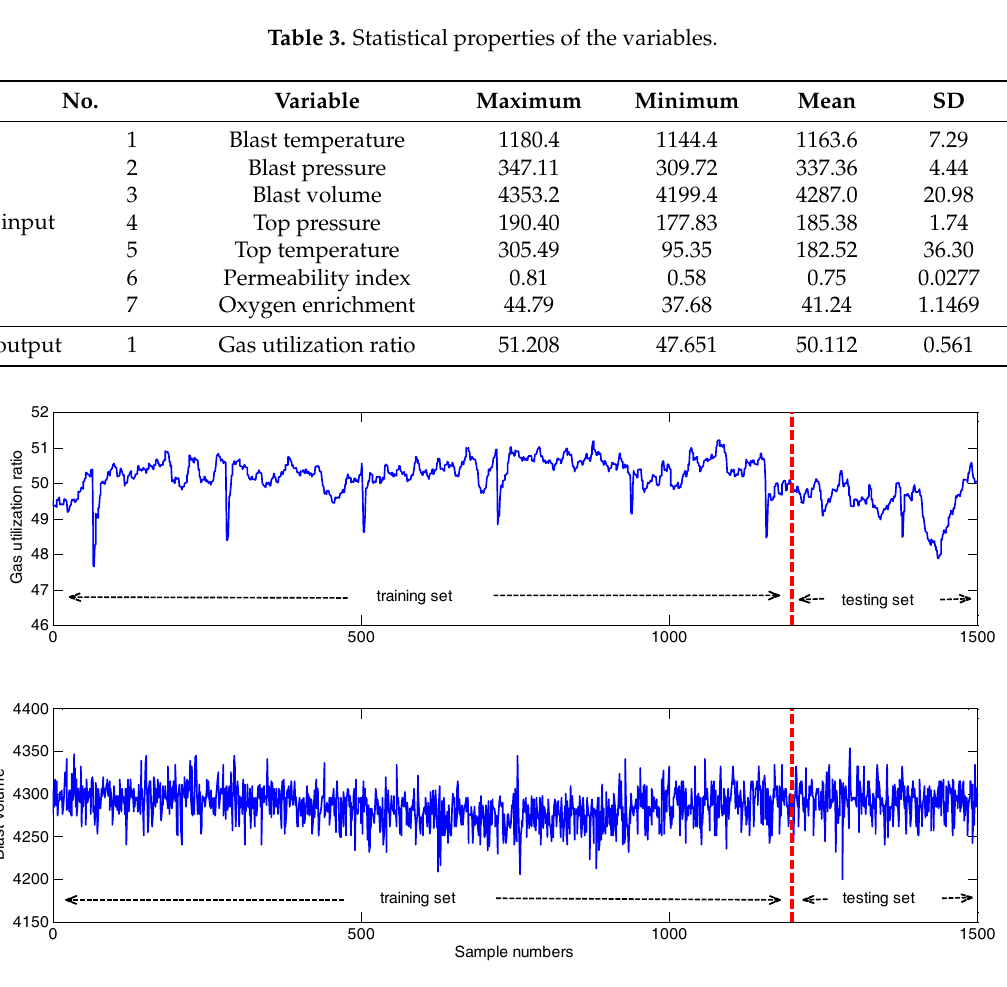
Figure 5. Series of GUR and blast volume in BF.